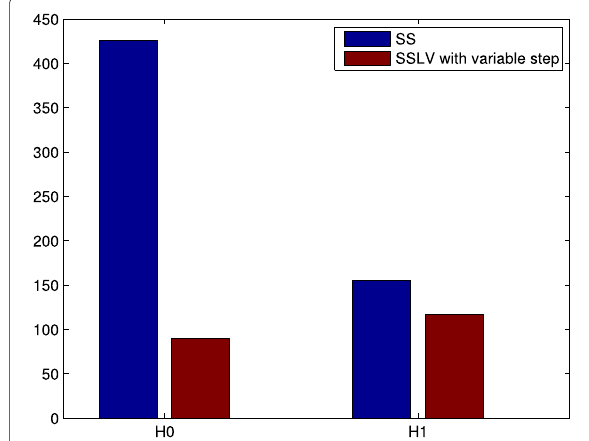
Fig. 9 Scan times versus different hypotheses. Here, we have N (cid:2) =